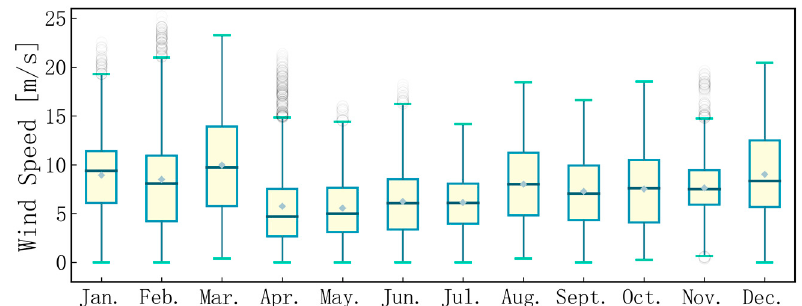
Figure 5. Diagram of monthly distribution of wind speed.